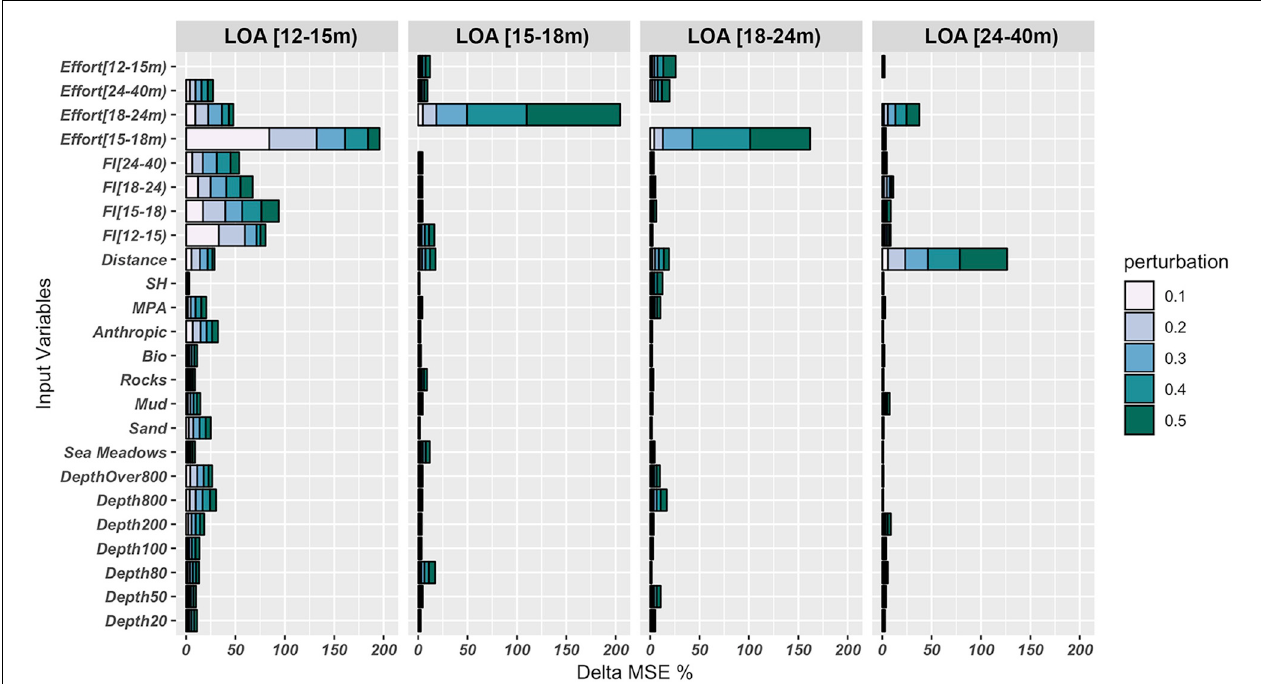
FIGURE 11 | Outputs of the sensitivity analyses based on the perturbation method. This procedure was applied for each input variable, by perturbing the input values at defined levels [initial values ± 0.1, ± 0.2, ± 0.3, ± 0.4, and ± 0.5], and then exploring the related effects on the output variables in terms of mean square error (MSE) between the predicted and observed values for the test. Bar lengths ( x -axis) represent the increase in the mean square error (MSE) of the CMPN 10 − 8 outputs obtained by perturbing each of the input variables in the test datasets, while keeping all other inputs at their original values, and are presented as stacked bars in which the color scale describes the size of the